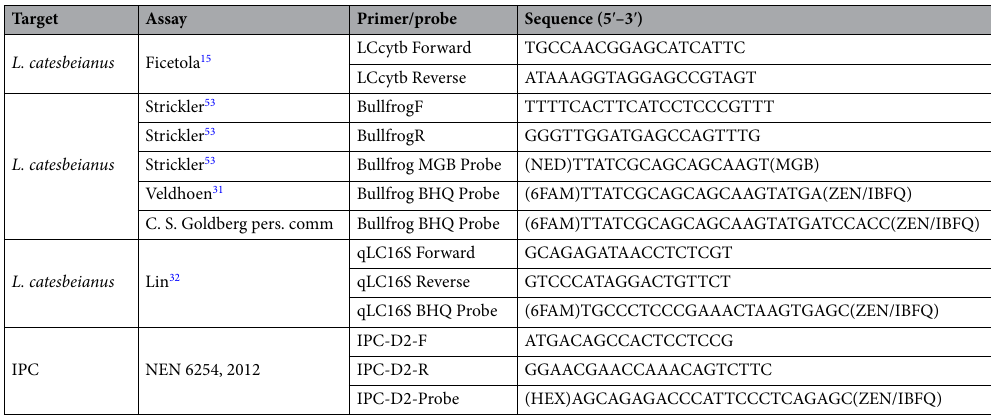
Table 1. Sequences of all published primers and probes targeting bullfrog DNA at the mitochondrial cytochrome b gene (Ficetola 15 , Strickler 53 /Veldhoen 31 /Goldberg) and at the 16S rRNA gene (Lin 32 ), as well as for the internal positive control (IPC) being a 149 bp plasmid insert sequence from the Dengue virus type 2 (INSDC